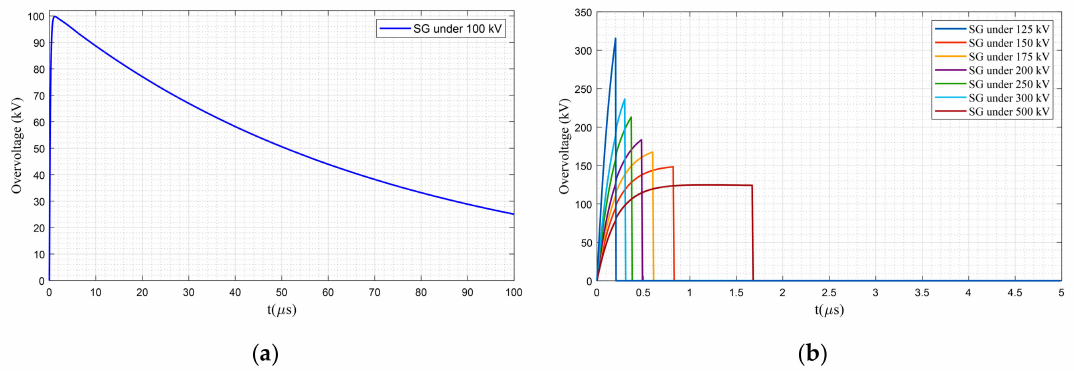
Figure 17. Overvoltage at the spark gap (SG) terminal for ( a ) not triggered condition and ( b ) triggered condition under di ff erent lightning